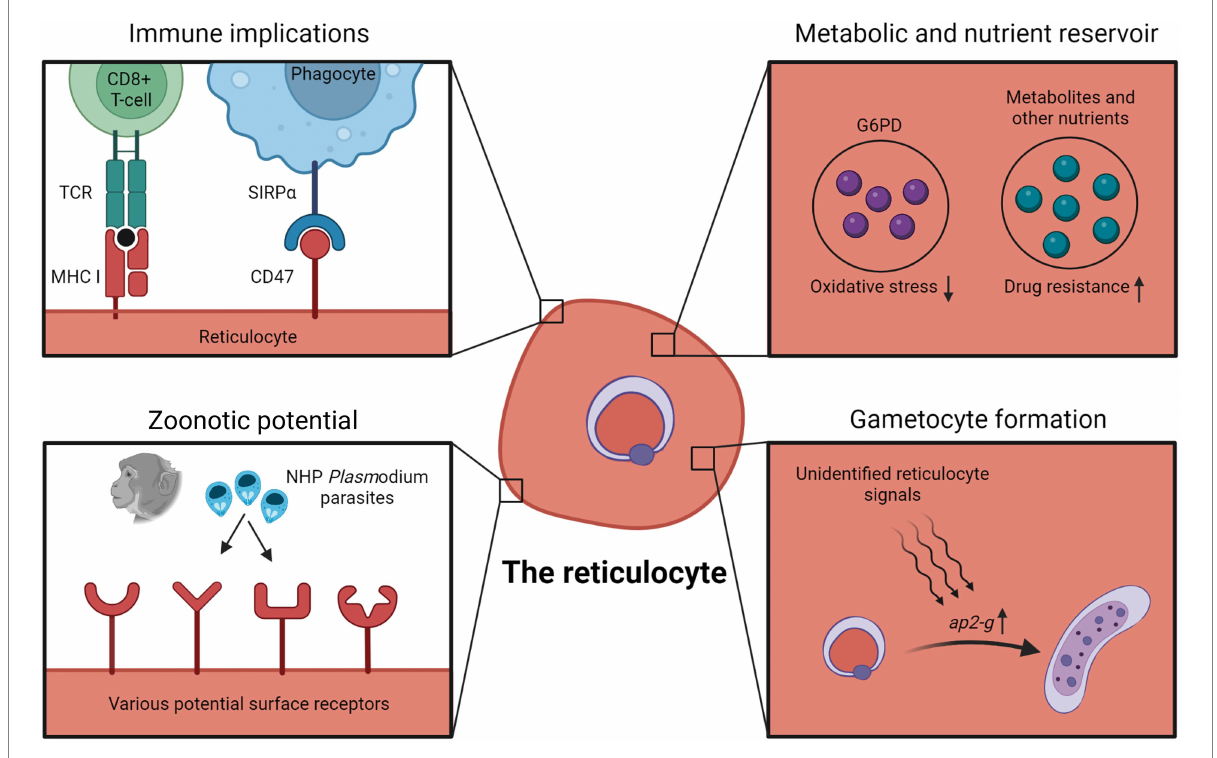
FIGURE 1 Advantages, disadvantages and implications of reticulocyte tropism. Infected reticulocytes have been shown to be recognizable by host CD8+ T cells due to MHC-I expression of reticulocytes. Early reticulocytes also express CD47 as a “do not eat me” signal to host phagocytes. Higher intracellular G6PD levels in reticulocytes has been postulated to protect parasites against oxidative damage. The relatively nutrient-rich microenvironment of the reticulocyte could also be capitalized by the parasite, and in some cases, enables the parasite to bypass metabolic pathways targeted by antimalarial drugs. Besides, observations with P. knowlesi and P. cynomolgi suggest that human reticulocytes might act as “gateways” to zoonotic transmissions due to the wide variety of potential receptors on reticulocyte surfaces. Data showing increased gametocyte formation in reticulocytes also hint at unidentified reticulocyte-specific signals inducing gametocyte conversion. Figure was created in Biorender.